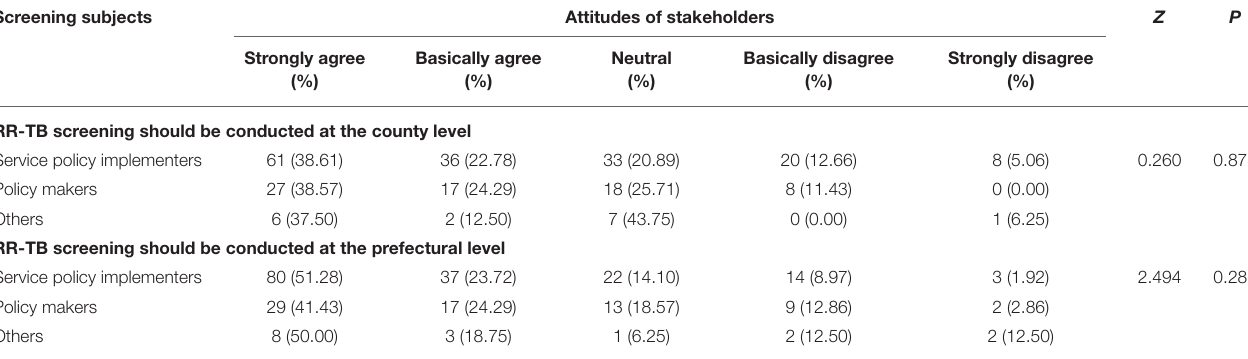
TABLE 9 | Attitudes of different categories of stakeholders among service providers toward implementation levels of RR-TB screening. Screening